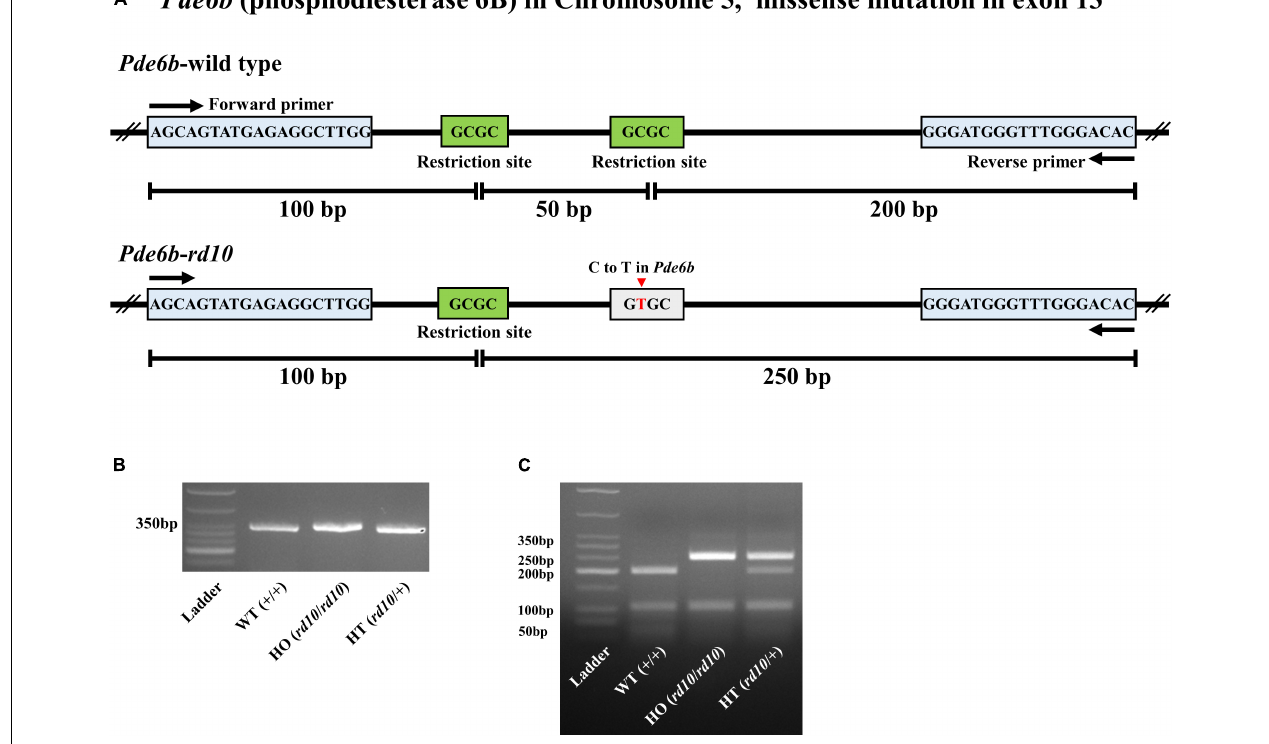
FIGURE 1 | Genotyping of C57BL/6- Pde6b em 1 ( R 560 C ) Dkl /Korl knockin mice. (A) The structures of the Pde6b -wild type allele and Pde6b - rd10 allele are shown. Mutation point exists in exon 13 of rod phosphodiesterase gene ( Pde6b ) located on chromosome five of wild-type (WT) mouse (C57BL/6J). The mutation point (C to T in Pde6b ) is presented by the red arrow. The primer binding sites are represented by the blue box. The restriction sites of Hha I are represented by the green box. (B) All PCR products of Pde6b from three different mice, wild-type (WT) (+/+), HO ( rd10/rd10 ), and HT ( rd10 /+), have the same size as 350bp. (C) Digestion of PCR products with Hha I yielded 3, 2, and 4 DNA fragments in WT (+/+), HO ( rd10 / rd10 ), and HT ( rd10 /+) samples, respectively.